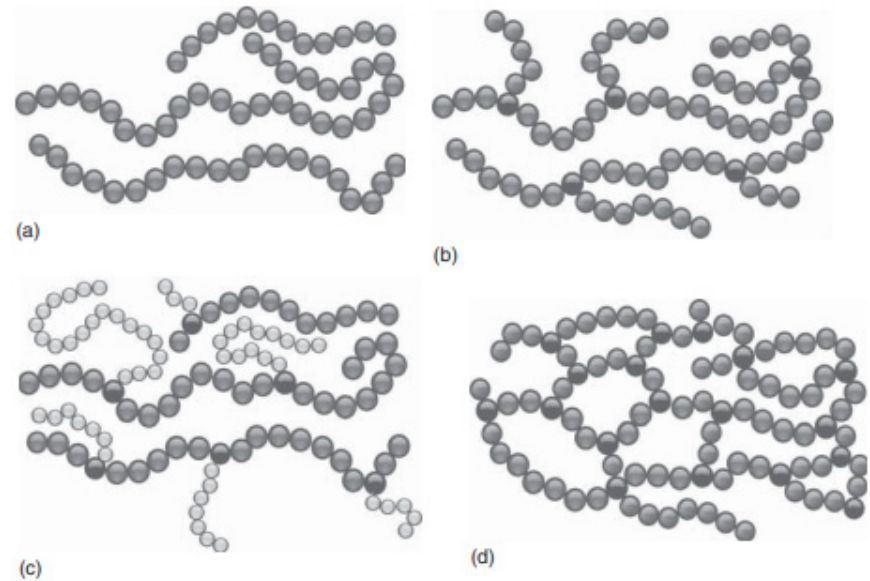
Figure 2. Types of polymers with various strand topologies: ( a ) linear polymer, ( b ) branched polymer, ( c ) graft polymer, and ( d ) reticulated polymer. Reprinted with permission from [91].